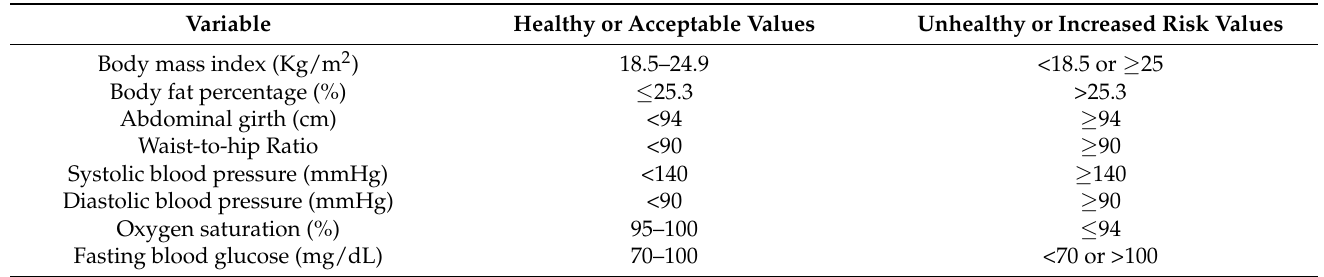
Table 1. Ranges established for each of the anthropometric or health variables included in the binary logistic regression analysis.